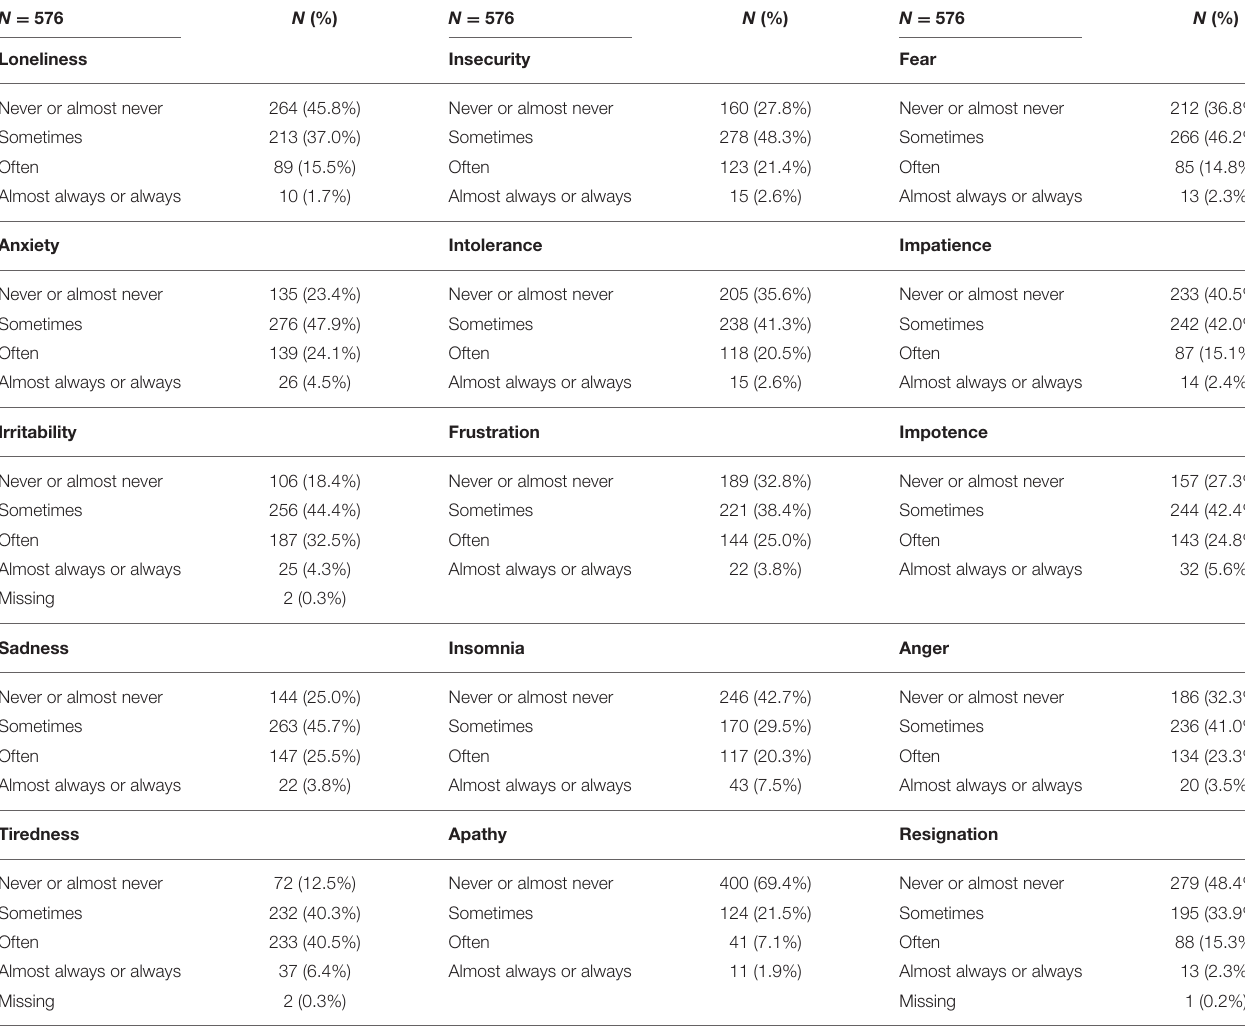
TABLE 2 | Self-reported prevalence of negative